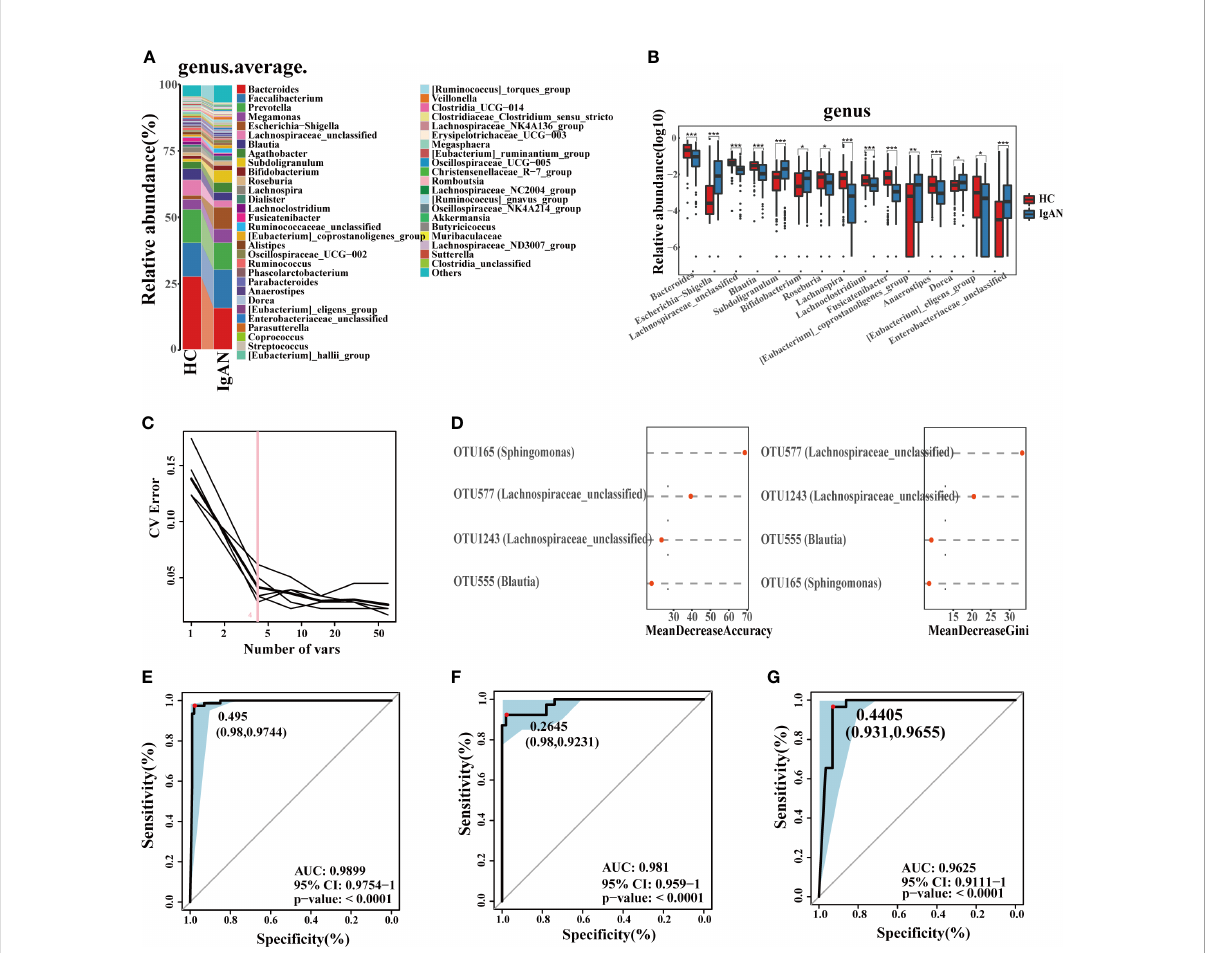
FIGURE 4 Phylogenetic pro fi les and diagnostic potential of gut microbes. (A) Comparison of microbial composition on genus level. (B) Comparison of differential microorganisms on genus level. Log 10 abundance of differential microorganisms on genus level. Statistically signi fi cant differences according to the Wilcoxon rank-sum test are marked with asterisks (* P < 0.05; ** P < 0.01; *** P < 0.001). (C, D) Four microbial OTUs were fi nally determined as the optimal marker set to diagnose IgAN by the random forest model between HC and IgAN. The POD values of the training phase (E) , test phase (F) and independent test phase (G) , obtained AUC values of 0.9899, 0.981 and 0.9625, respectively. CV, coef fi cient of variation; OTUs, Operational Taxonomic Units; POD, probability of disease; CI, con fi dence interval; AUC, area under the